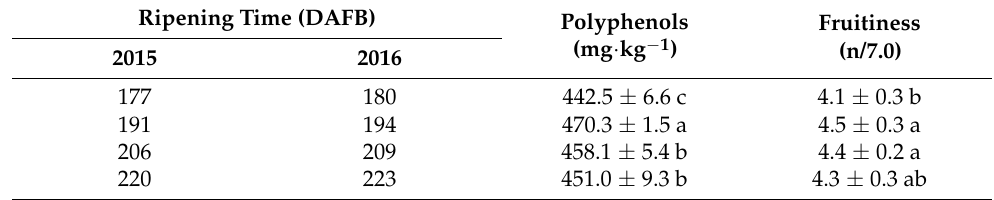
Table 8. Total polyphenols content (mg caffeic acid · kg − 1 ) and fruitiness median of ‘Lecciana’ oils during ripening (DAFB = days after full bloom). Mean values of two subsequent seasons ( ± SE ). Lower case letters denote statistical differences at p = 0.05 (Siegel-Tukey